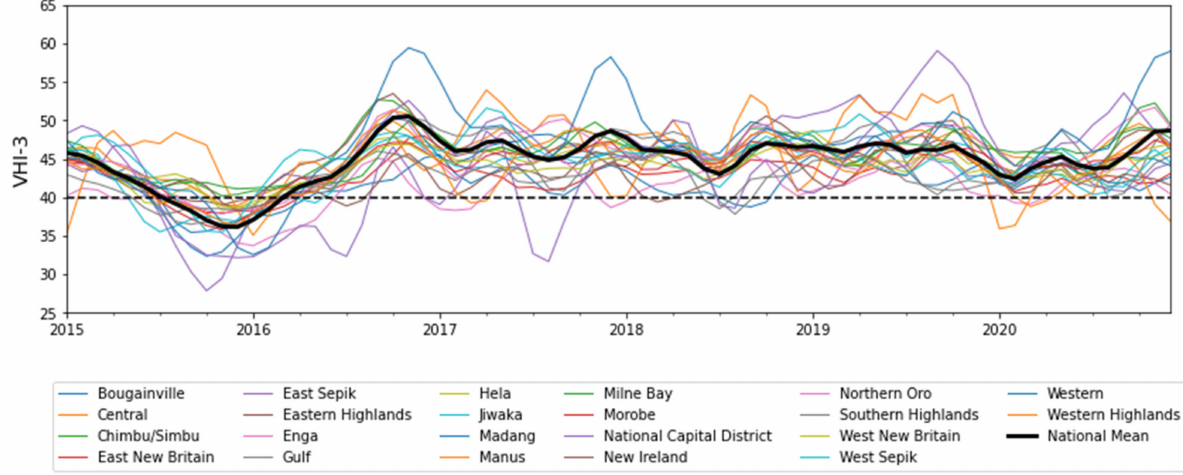
Figure 8. VHI-3 averaged over 22 PNG provinces from 2015 to 2020 and compared to the national mean (in bold black).